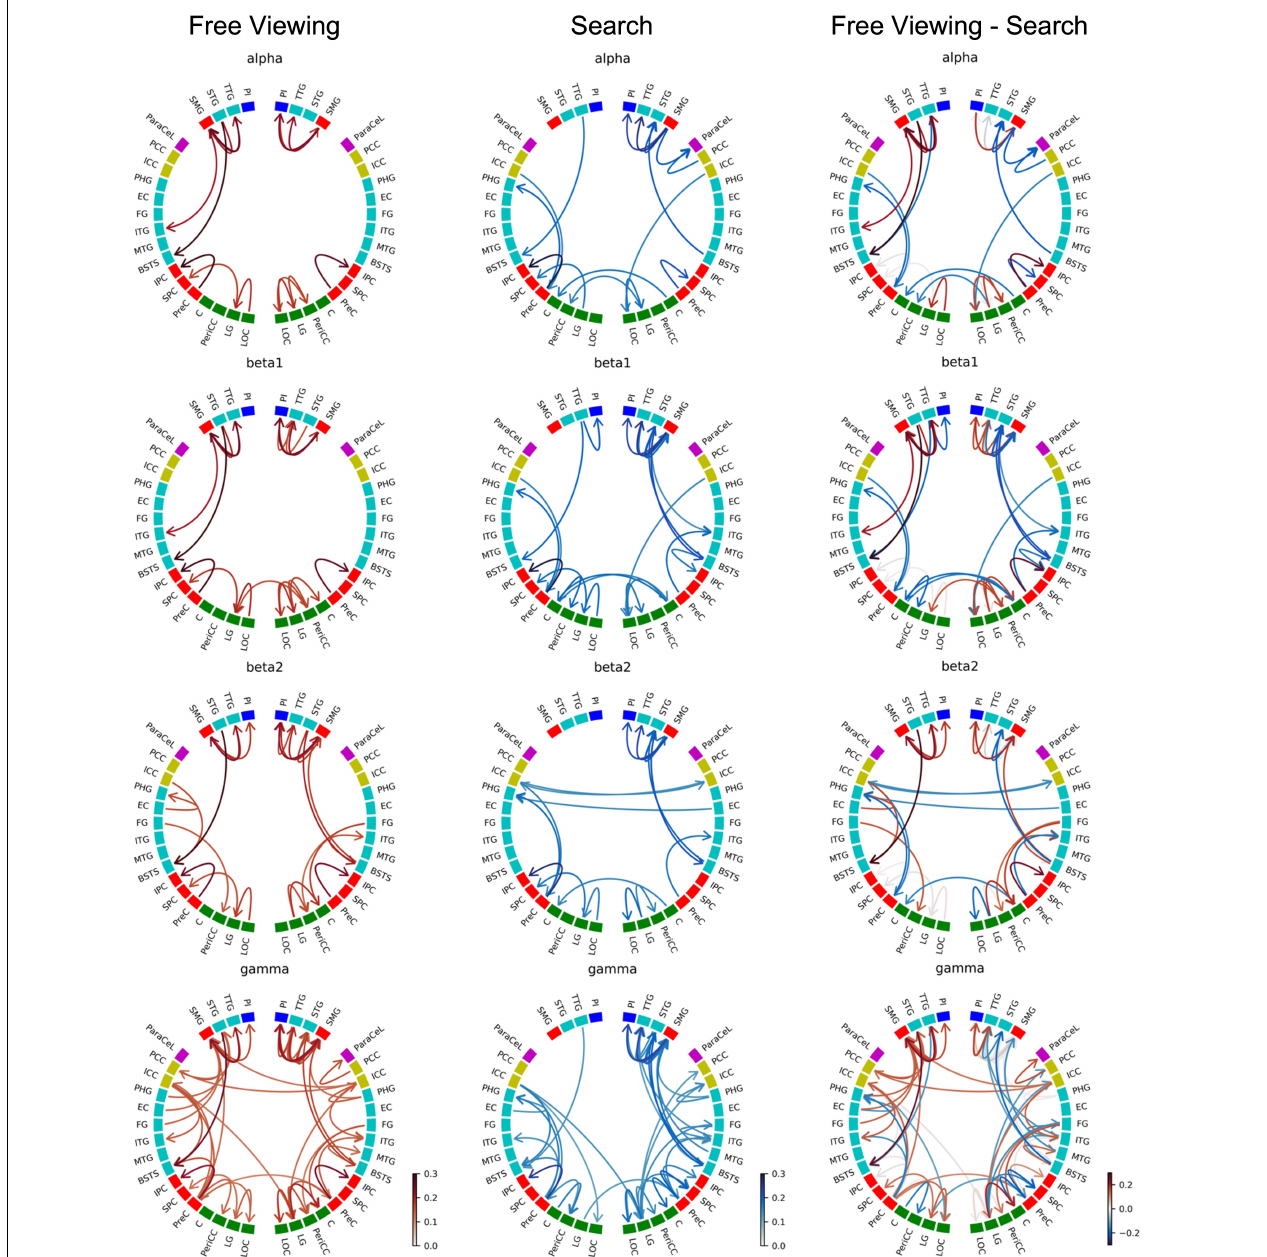
FIGURE 7 | Causality group results (GPDC) for fixation onset during FV, VS, and the direct comparison between FV and VS where the causality matrix containing the group results for VS was subtracted from the causality matrix containing the group results for FV. Red arrows indicate that the connection was stronger during FV, while blue arrows indicate that VS dominated. Gray arrows indicate that the connections were of comparable strength during FV and VS. The ROIs are ordered by hemisphere and cluster (TPC and DC). The color of the nodes indicates the anatomical higher-level region (frontal lobe: magenta, insula: blue, cingulate cortex: yellow, temporal lobe: turquoise, parietal lobe: red, occipital lobe: green). Results from the delta and theta band can be found in Supplementary Material